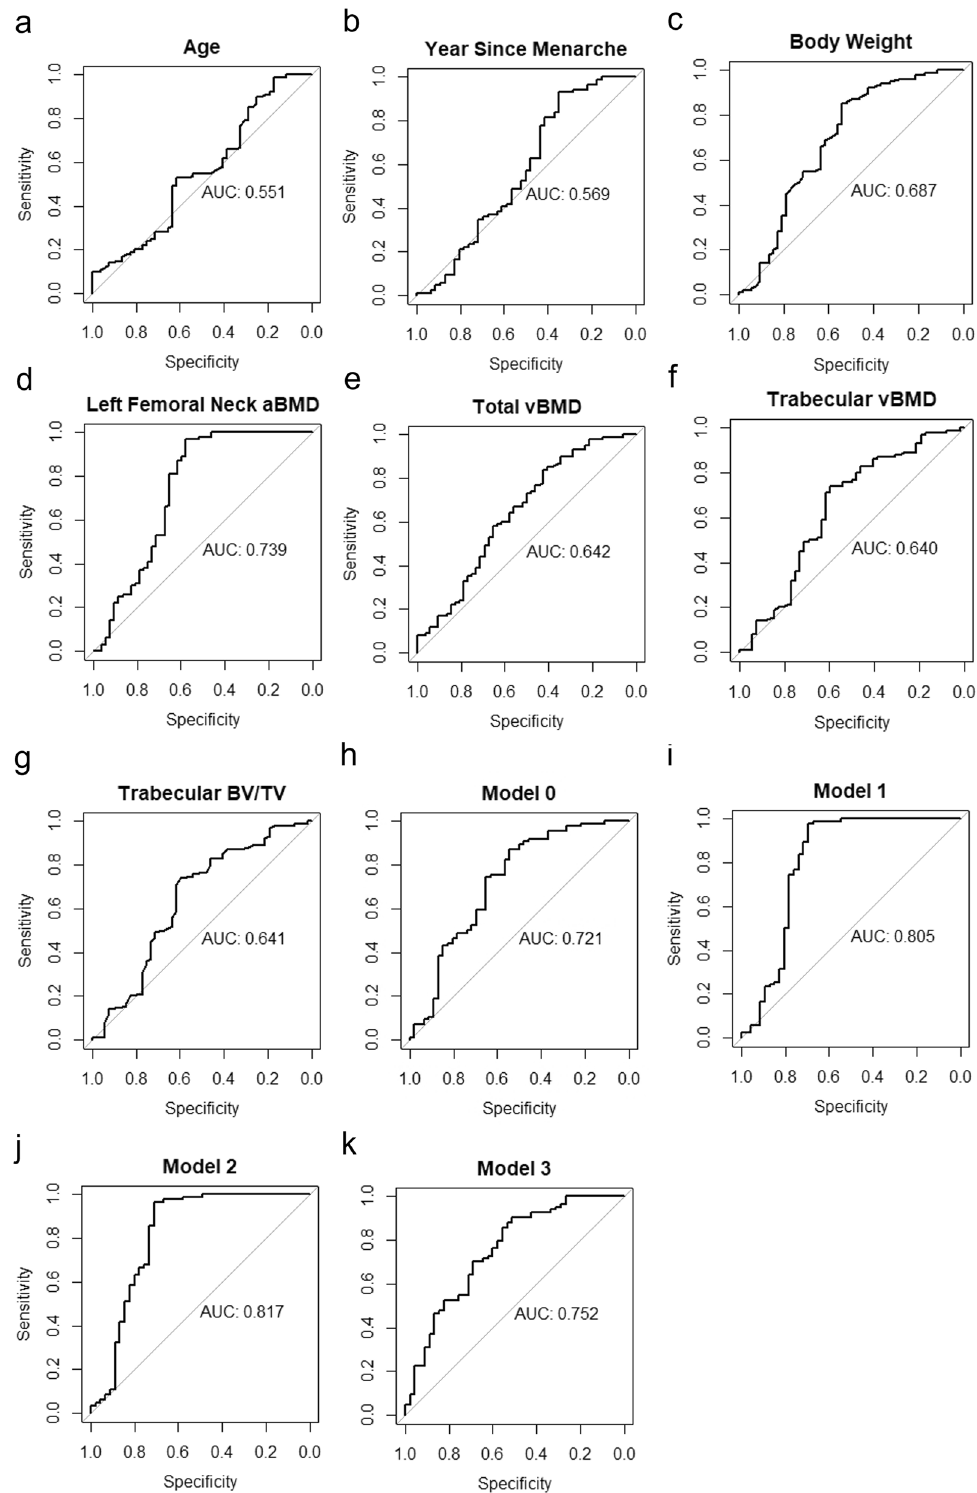
Figure 4. ROC curves and AUC of variables and logistic regression